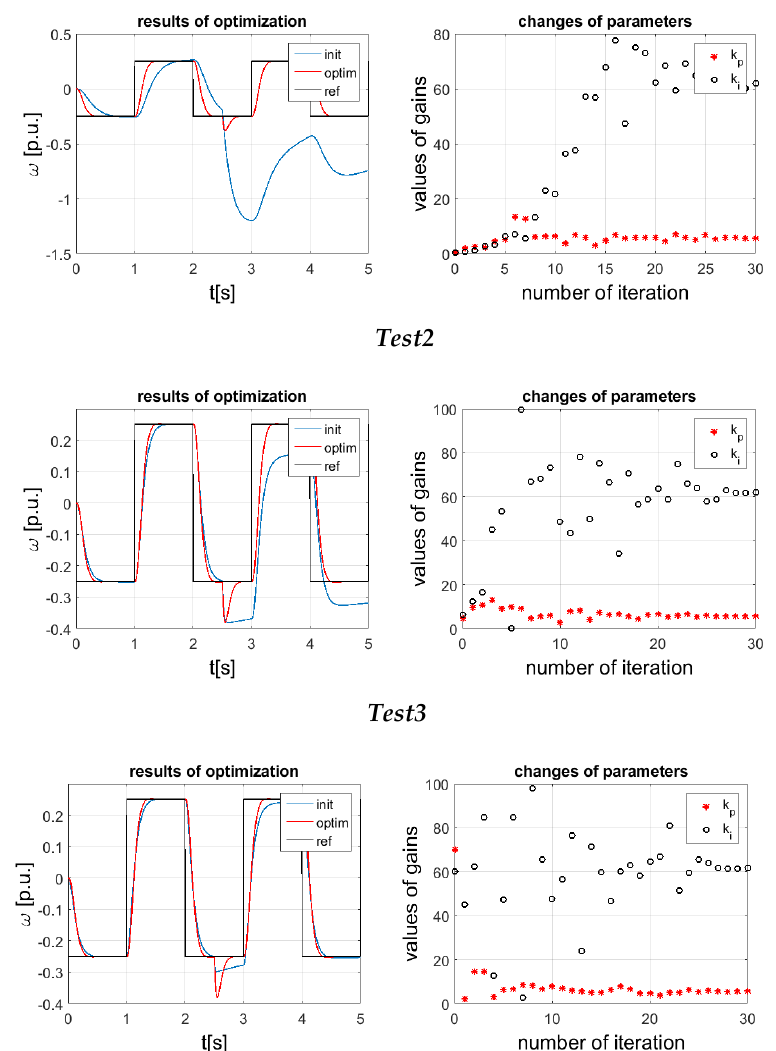
Table 1. The influence of the initial value selection on the final optimization results.